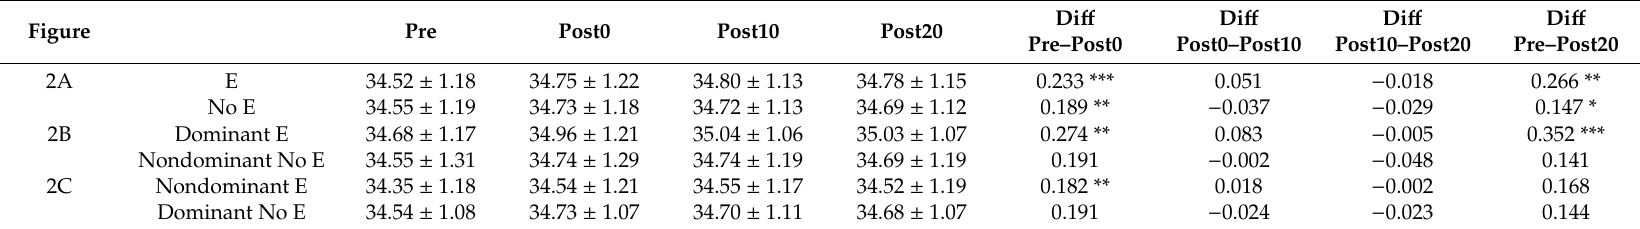
Table 1. Temperature from each of the measurements (mean ± SD) and temperature change between one and other measures (di ff erence (Di ff ) Pre–Post0; Di